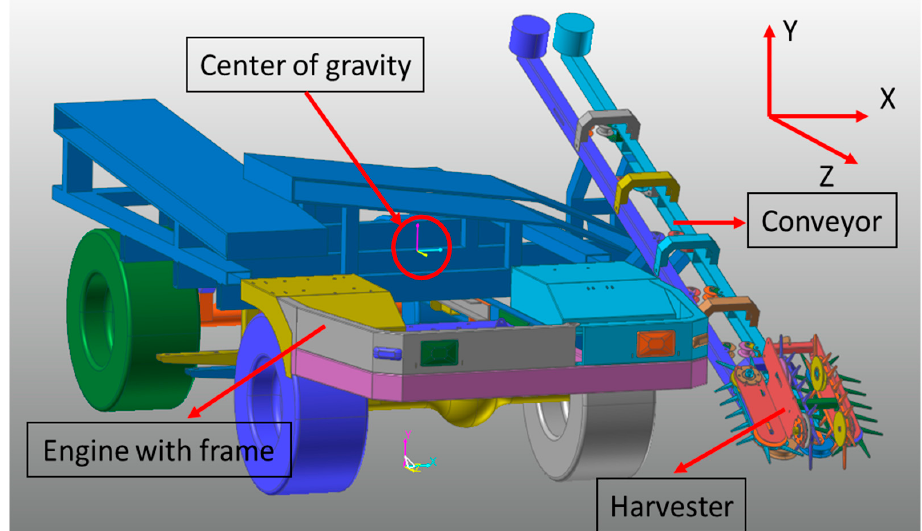
Figure 2. The 3D model of the radish harvester used in this study. Table 2. The simulation parameters of the 3D model of the radish harvester used in this study. Parameters Values Weight (kg) 1350 Center of gravity 186.5, 710, − 300 I xx (kg · m 2 Moment of inertia 1318